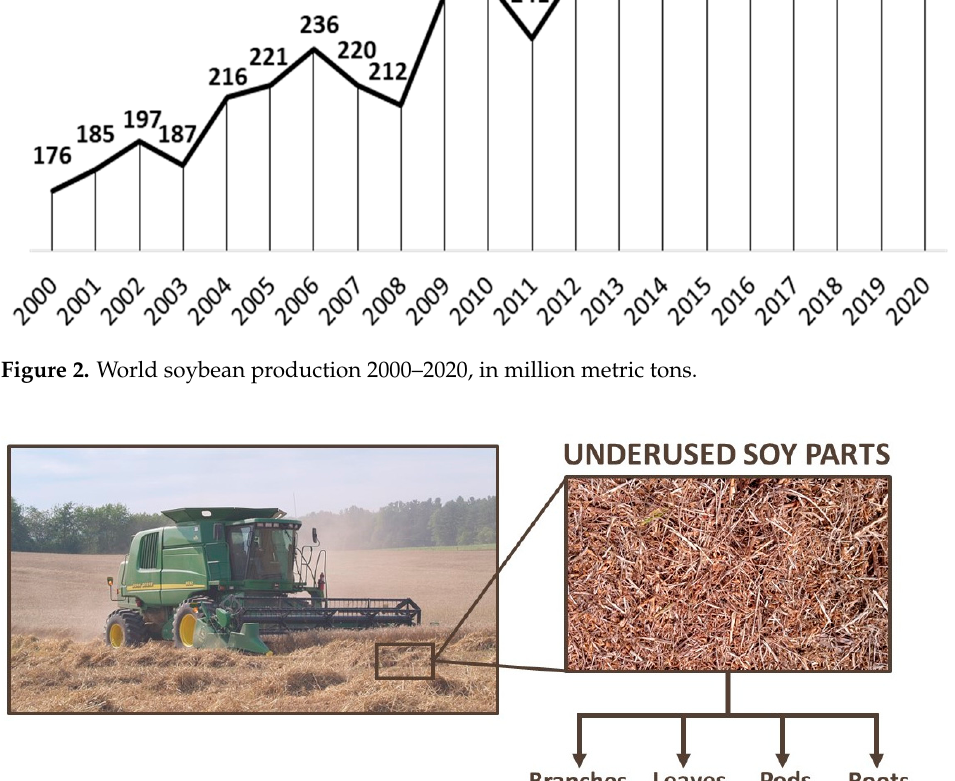
Figure 3. Underused soy parts left on the soil just after the soybean